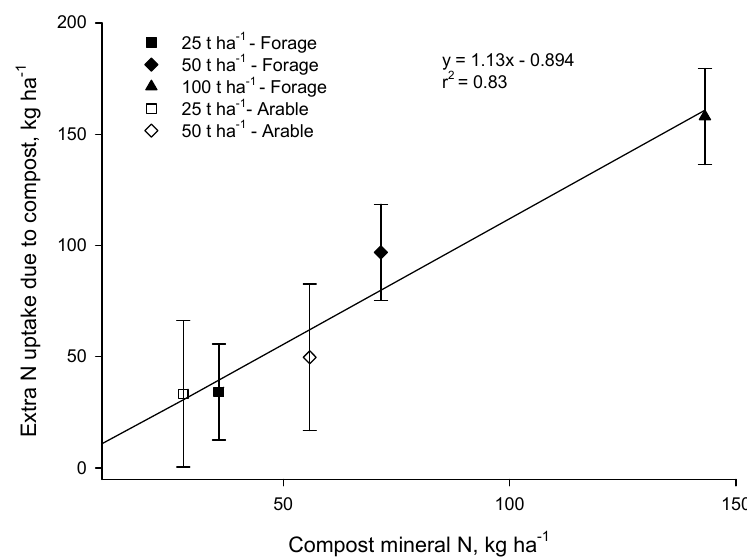
Figure 5. Relationship between N recovered by kale and maize (the first crops grown in the Forage and Arable trials) from compost and the input of mineral N in compost. The error bars represent 95% confidence intervals.